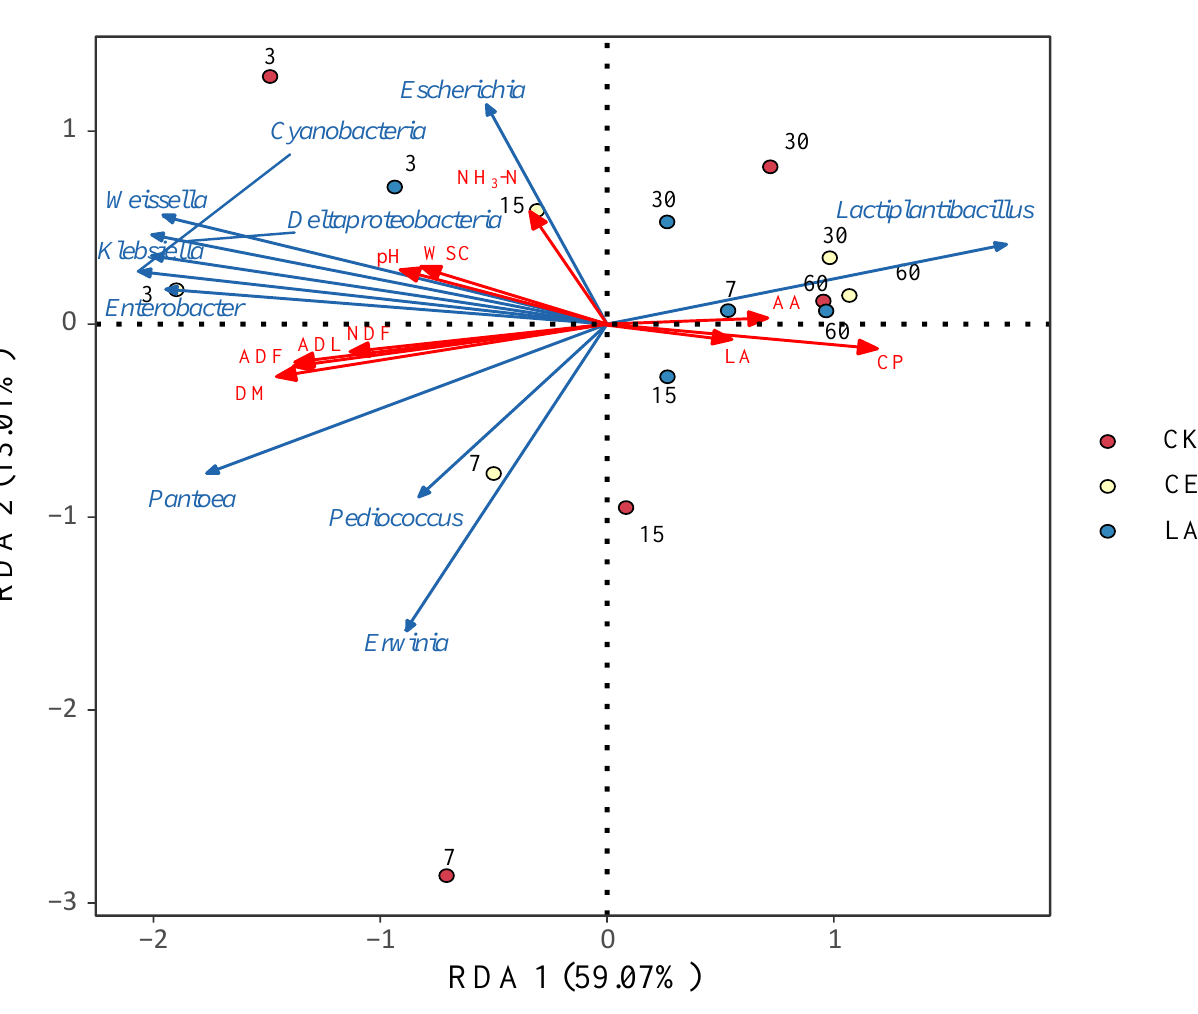
Figure 4. Redundancy analysis (RDA) ordination diagram related to the bacterial with explanatory (e.g., pH; NH 3 -N, LA, AA, DM, NDF, ADF, ADL, CP, WSC) variables represented as arrows by 16S rRNA sequencing. pH, potential of hydrogen; LA, lactic acid; AA, acetic acid; NH 3 -N, ammonia nitrogen; DM, dry matter; NDF, neutral detergent fiber; ADF, acid detergent fiber; ADL, acid detergent lignin; CP, crude protein; WSC, water-soluble carbohydrates.